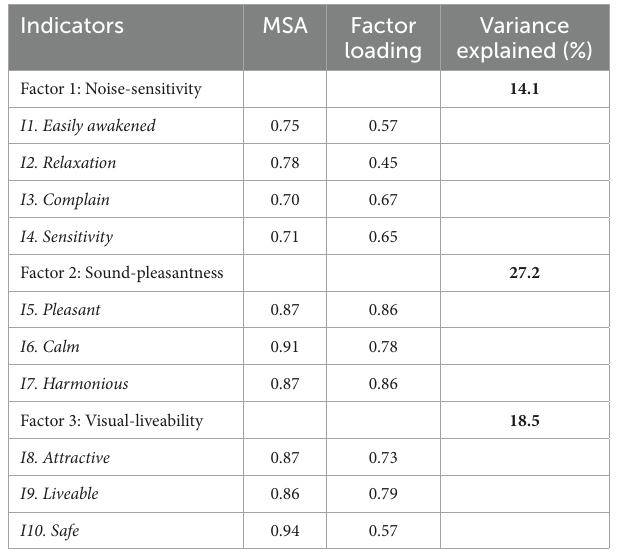
TABLE 5 Factor loadings for the analysis EFA